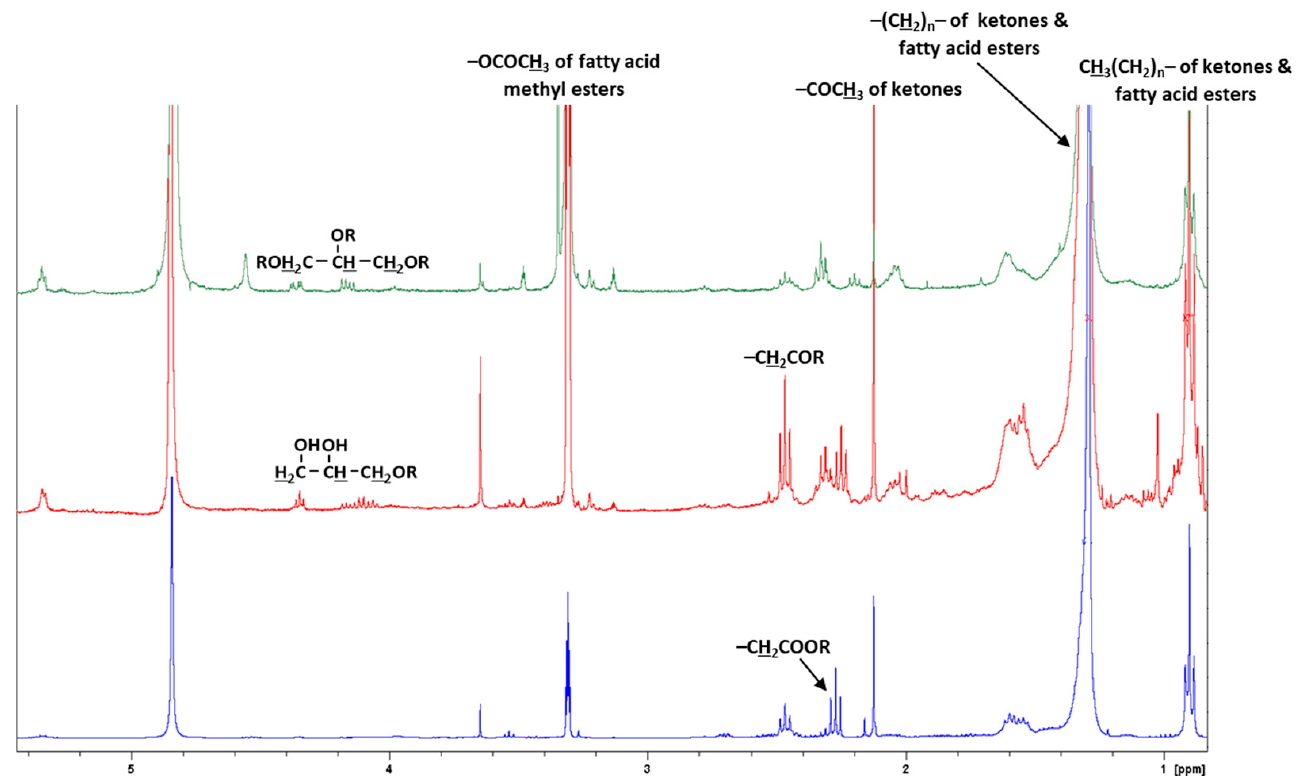
Figure 2. 1 H-NMR spectra (CD 3 OD, 400 MHz) of the fractions AE, AG, and AI.